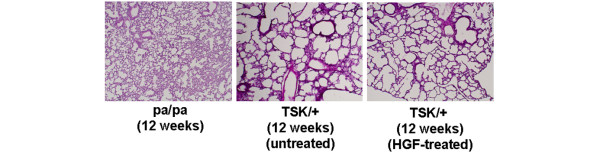
Effect of HGF on pulmonary changes in TSK/+ mice. Representative histologic sections stained with hematoxylin and eosin are shown (× 40). HGF, hepatocyte growth factor; TSK/+, tight skin.